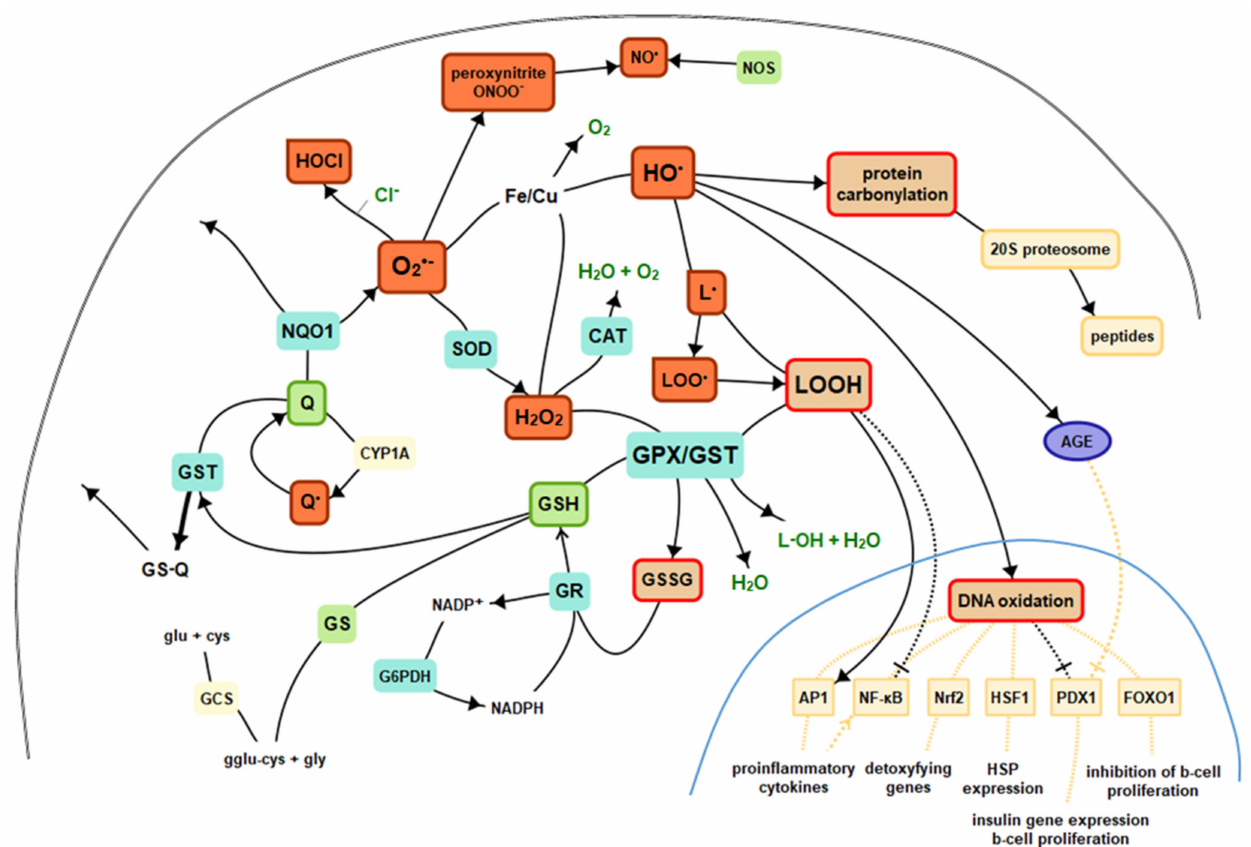
Figure 2. Basics of intracellular antioxidant mechanisms and nuclear signaling. Legend: CAT—catalase, GPx—glutathione peroxidase, GR—glutathione reductase, GST—glutathione S-transferases, GSH—reduced glutathione, GSSG—oxidized glutathione, Q—coenzyme Q 10 , GS—glutathione synthetase, HO · —hydroxyl radical, H 2 O 2 —hydrogen peroxide, L · — alkyl radical, LO · —alkoxy radical, LOO · —peroxy radical, HOCl—hypochlorous acid, NO—nitric oxide, NOS—nitric oxide synthase, NQO1—NADPH-quinone oxidoreductase-1, O 2 —molecular oxygen , O 2 • — superoxide, SOD—superoxide dismutase, AGE—advanced glycation end products, NF- κ B—nuclear factor kappa-light-chain-enhancer of activated B cells, AP1—activator protein 1, Nrf2—nuclear factor-erythroid 2-related factor 2, HSF1—heat shock factor 1, PDX1—insulin promoter factor 1, FoxO—forkhead transcription factor